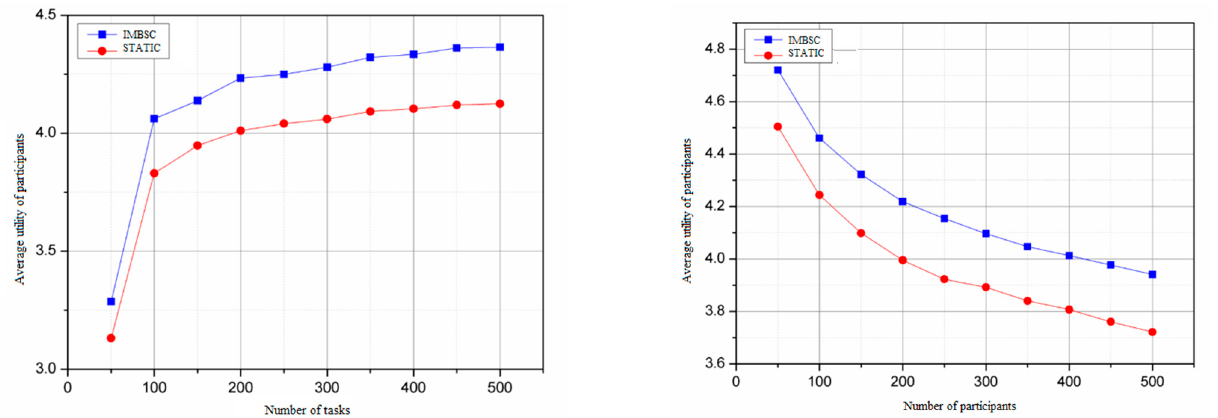
Figure 3. Average utility of participants.